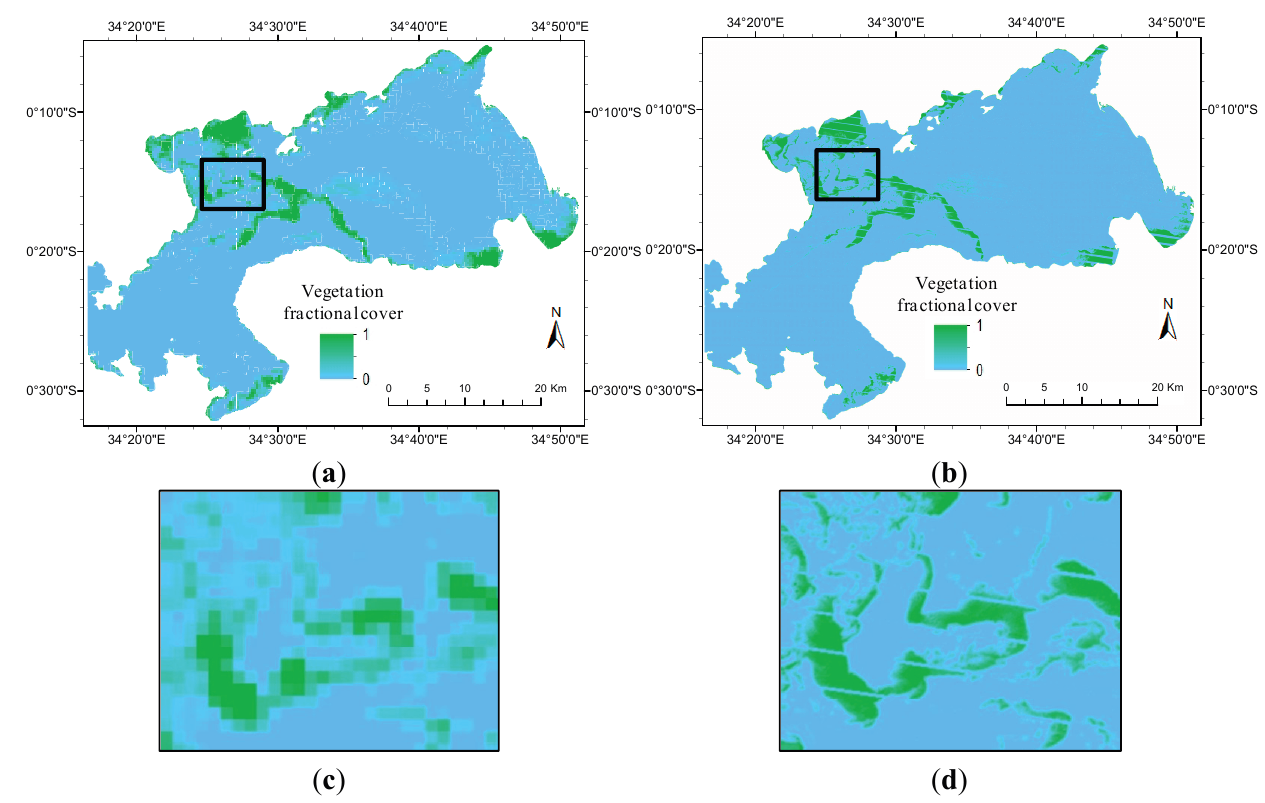
Figure 10. The spectral unmixing classification results of ( a , b ) MERIS and ( c , d ) ETM+. from blue (open water surface) to green (fully The images show increasing f v